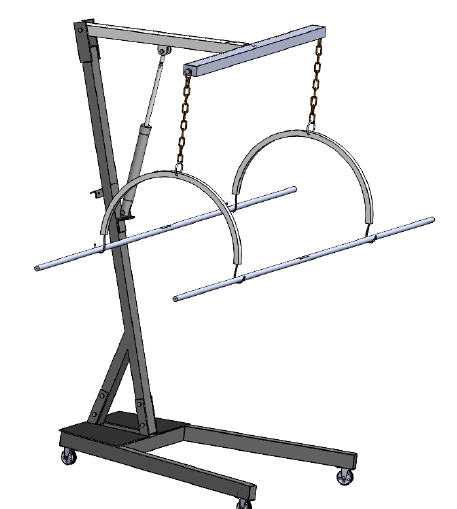
Figure 9. The proposed CAD